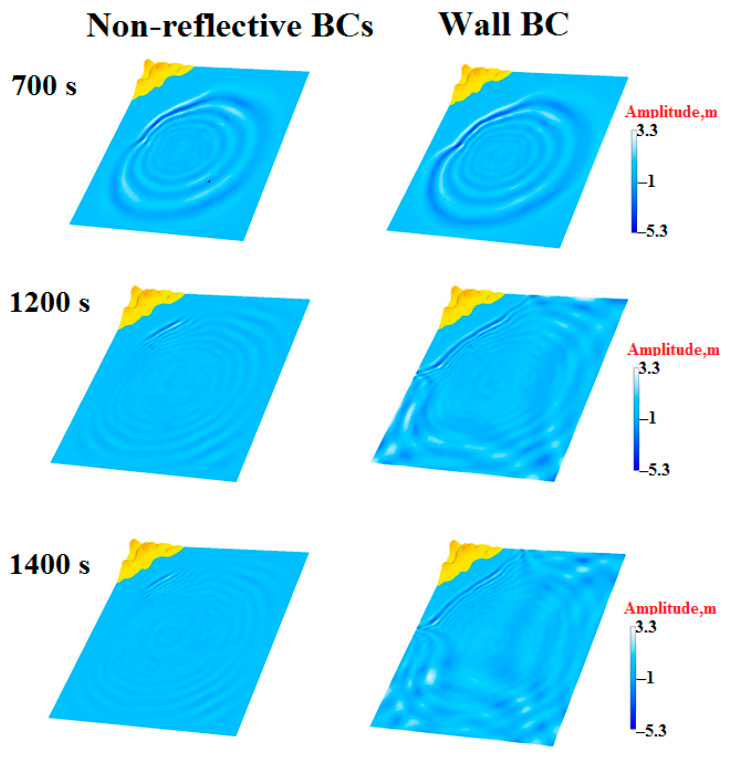
Figure 8. Time series of free surface position.